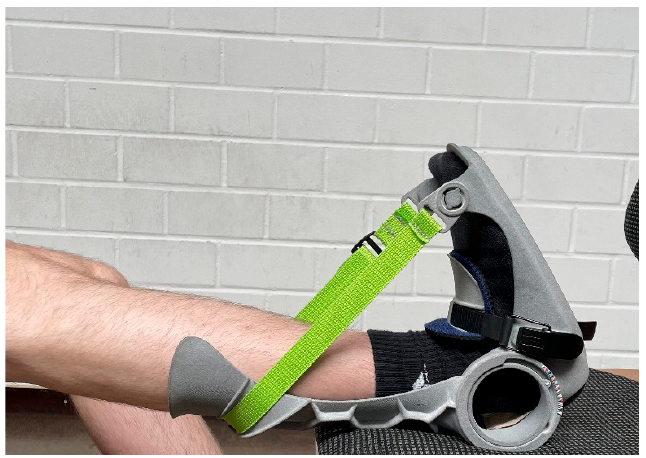
Figure 2. Orthosis used for calf-muscle stretching.